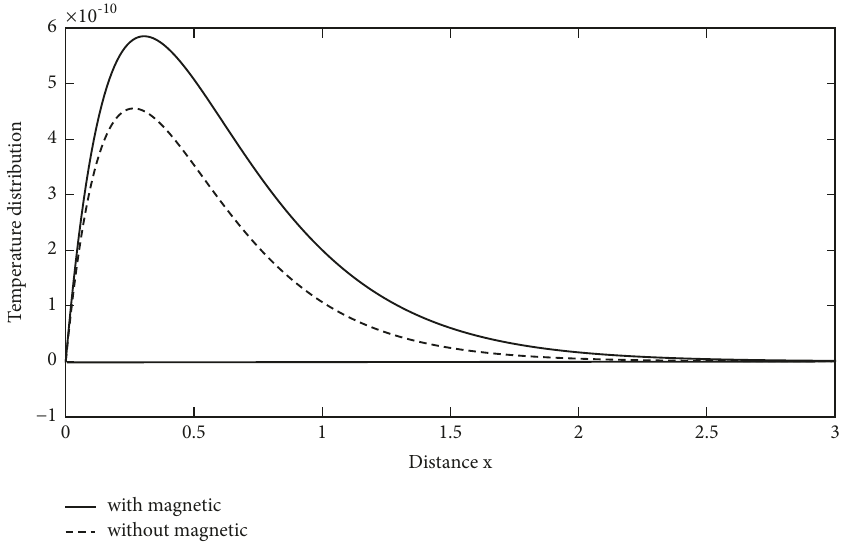
Figure 13: Effect of magnetic field on temperature